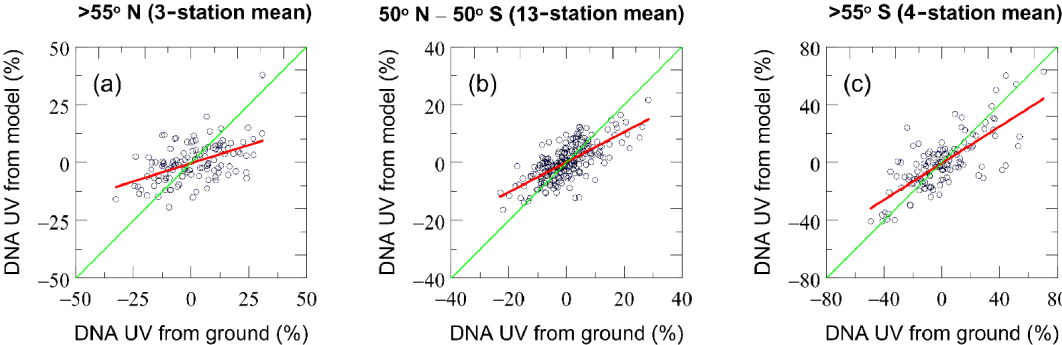
Figure 2. Scatter plots of DNA-active irradiance from simulated and ground-based data shown in Fig. 1 for (a) 3 UV stations in the northern high latitudes ( > 55 ◦ N), (b) 13 UV stations from 50 ◦ N to 50 ◦ S, and (c) 4 UV stations in the southern high latitudes ( > 55 ◦ S).